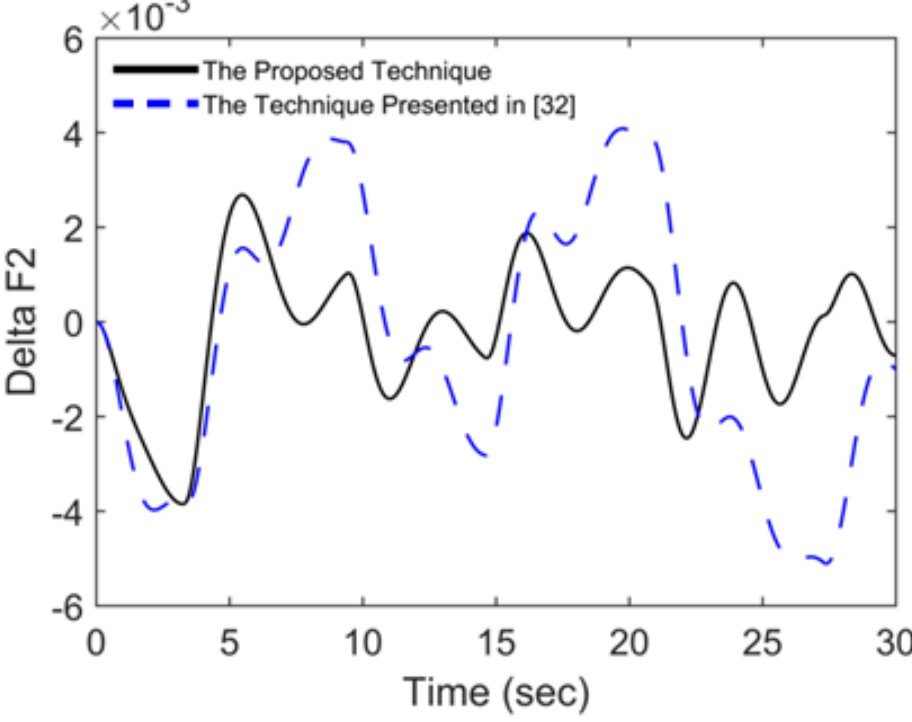
Figure 11. Frequency deviation (p.u.) in area 2 under the variation in WECS as a disturbance.